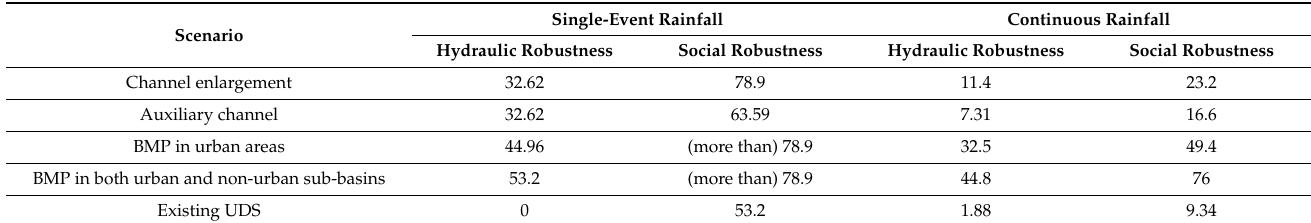
Table 4. The value of UDS resistance capacity ( RC ) under different